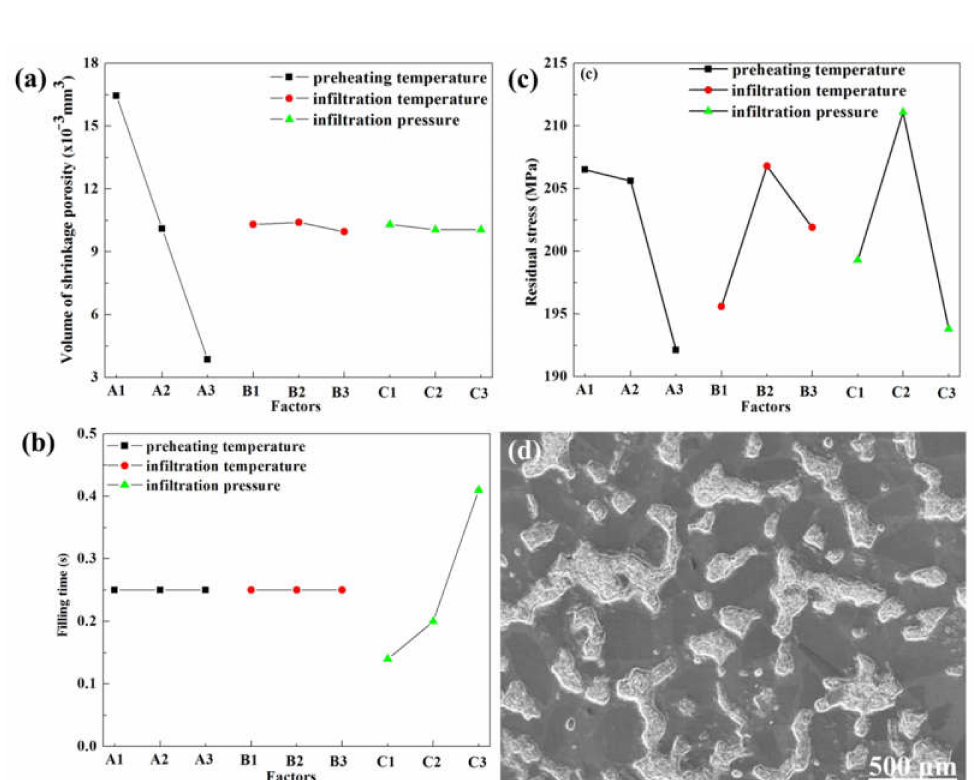
Figure 7. K values for three ( a ) volumes of shrinkage porosity factors, ( b ) filling times, and ( c ) maxi- mum equivalent stress values; ( d ) SEM micrograph of the